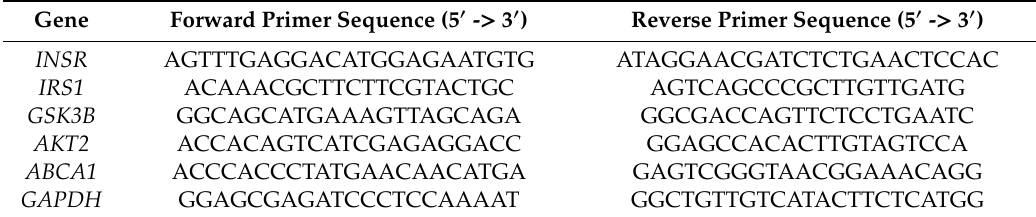
Figure A1. Comparison expression levels of the selected housekeeping RNA molecules: ( A ) GAPDH in Huh7 cells, p = 0.204, ANOVA; ( B ) U6 in Huh7 cells, p = 0.661; ( C ) 18s in mouse, 18S p = 0.464; and ( D ) U6 in mouse, p = 0.139. One-way analysis of variance (ANOVA) was used to determine whether a significant di ff erence in GAPDH, 18s and U6 values existed between multiple groups. Table A1. List of primers used for qRT-PCT analysis in Huh7 cells. Gene Forward Primer Sequence (5 (cid:48) - > 3 (cid:48)